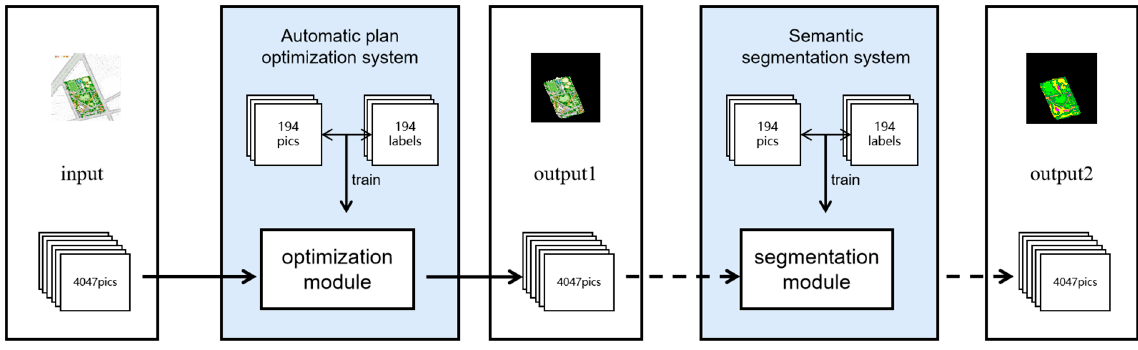
Figure 7. The overall work fl ow of data augmentation.